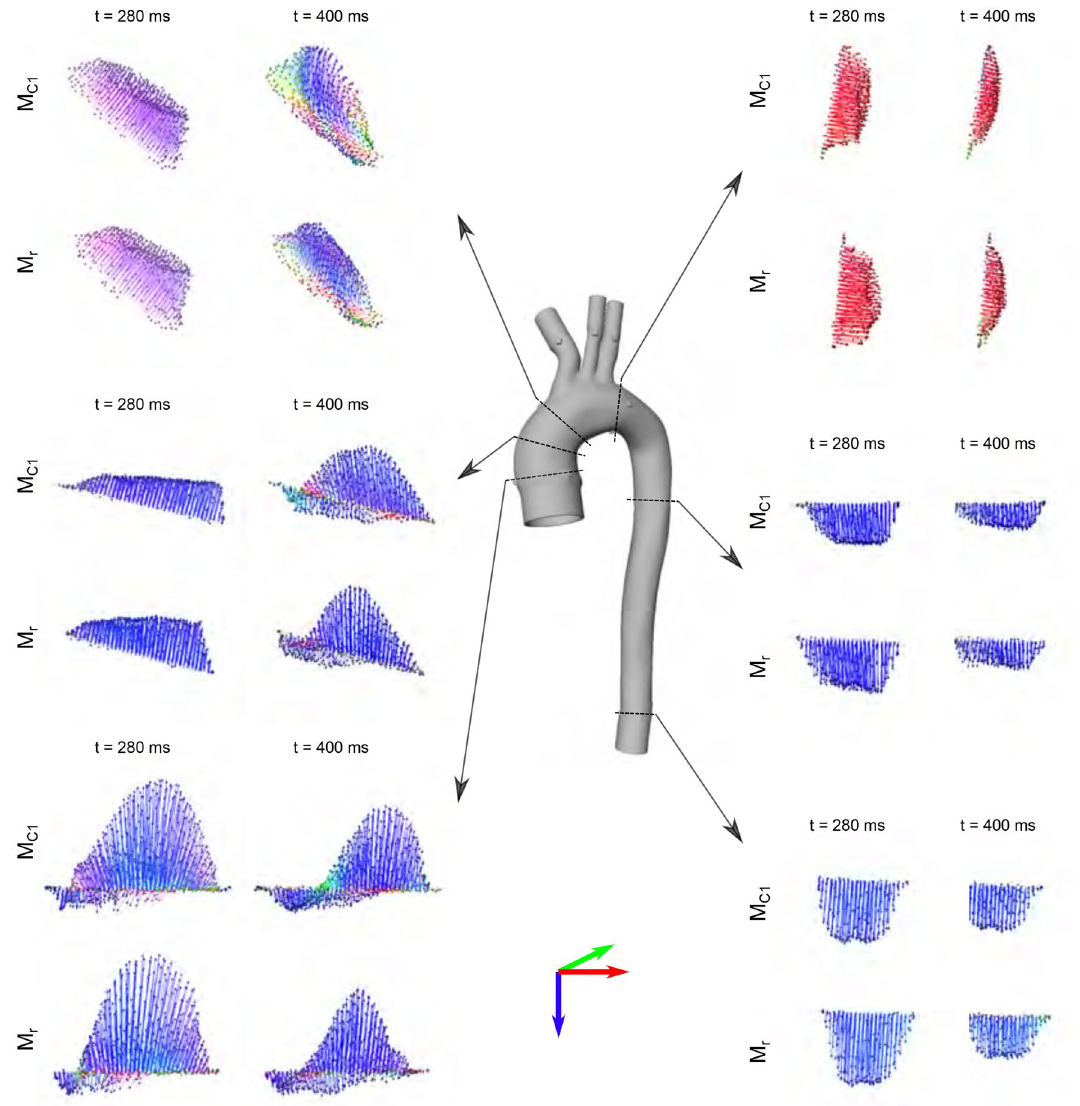
Figure 4. 4D-flow cross-sectional velocity profiles in models M c1 (top) and M r (bottom) at peak-systolic ( t = 280 ms ) and end-systolic ( t = 400 ms ) frames. All profiles are 3D-rendered using the identical camera view and colored according to the 3D direction (red-green-blue arrow legend). Backward flow is visible at cross-sections prior to the arch branches (inlet, AAo, BCT), specifically at end-systole. One can appreciate the different vector profiles for the compliant model M c1 when compared to the nearly rigid model M r . Velocity profiles rendered using MevisLab (v3.4a, https:// www. mevis lab.